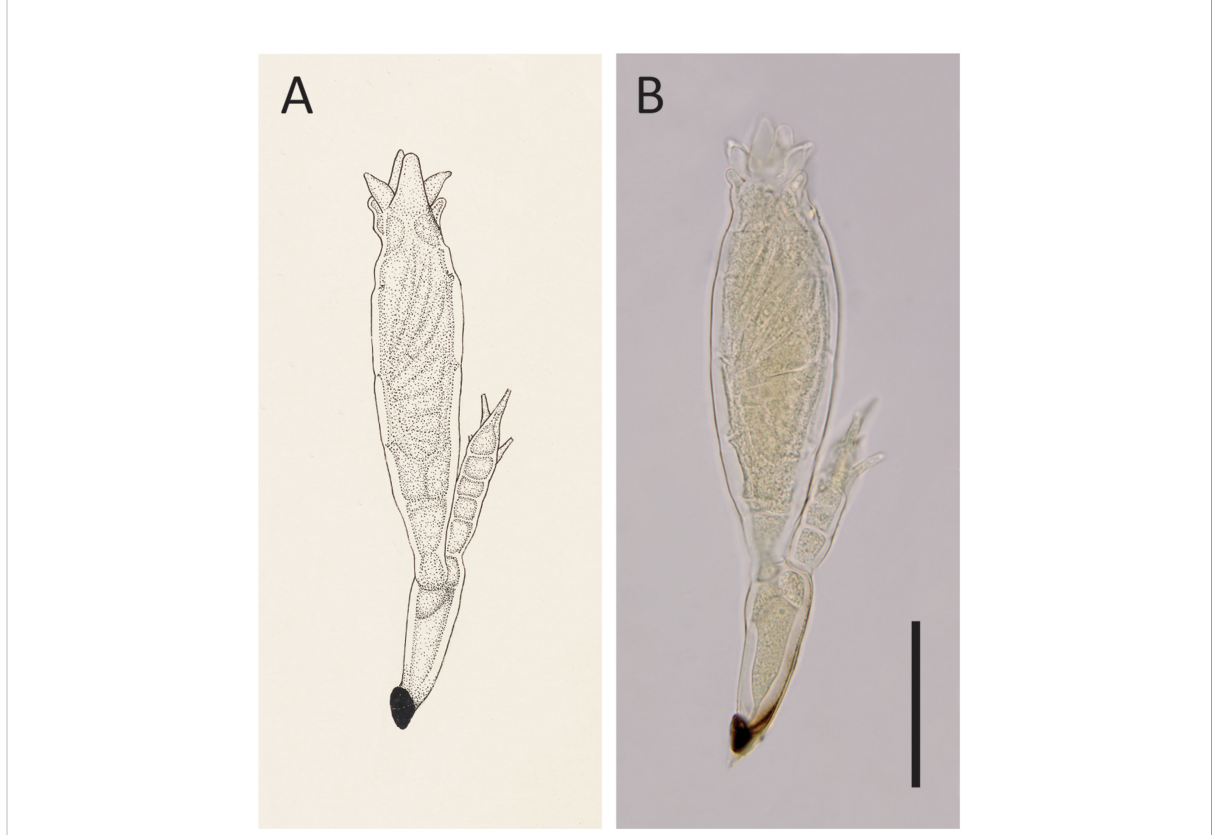
FIGURE 4 Hesperomyces hyperaspidis Thaxt., slide FH 4989 (holotype). (A) An enlargement of Thaxter ’ s (1931) original Plate XX: Figure 22. Courtesy of the Archives of the Farlow Herbarium of Cryptogamic Botany, Harvard University. (B) Photo of the same thallus that stood model for Thaxter ’ s drawing. Scale bar 50 m